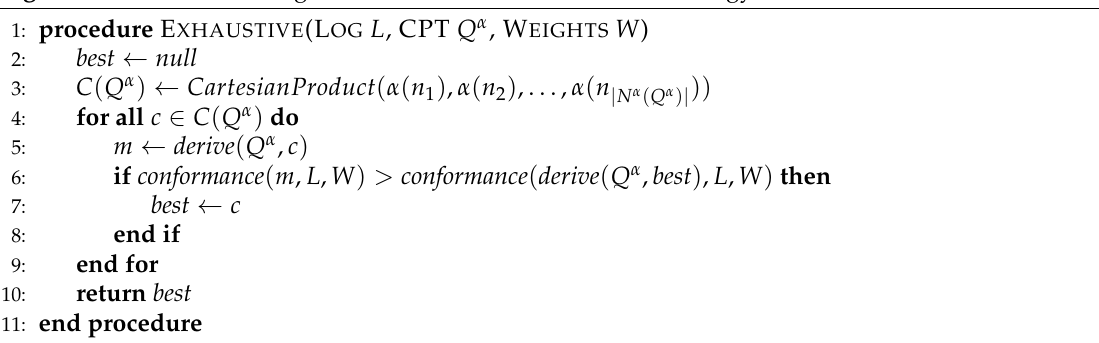
Algorithm 1 Obtain a configuration based on the exhaustive